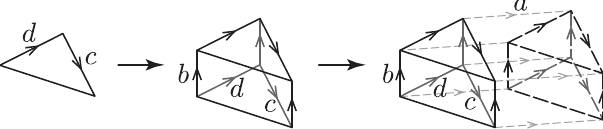
FIG. 6. Evolution from a triangle to a 4D manifold.